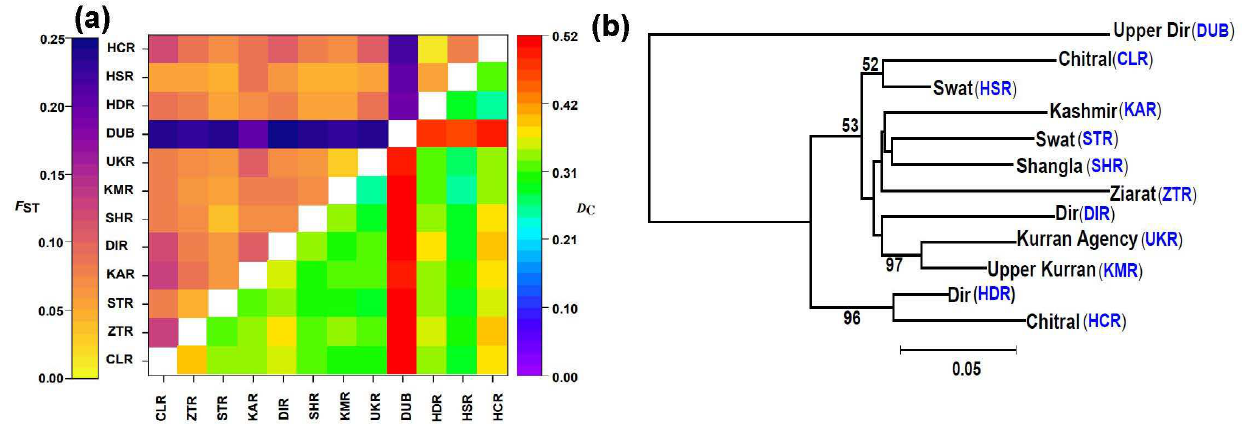
Figure 2. Genetic differentiation, distance and phylogenetic relationship among the studied popula- tions. ( a ) Heat map for the pairwise genetic distance among populations. The upper part represents F ST while the lower part denotes the Dc (Cavalli-Sforza). The values were computed based on 1000 permutations. ( b ) Neighbor-joining tree showing genetic relationships among 12 populations of walnut produced from 31 SSR markers. Table 3. Hierarchical AMOVA results among 12 walnut populations generated from 31 SSR loci.